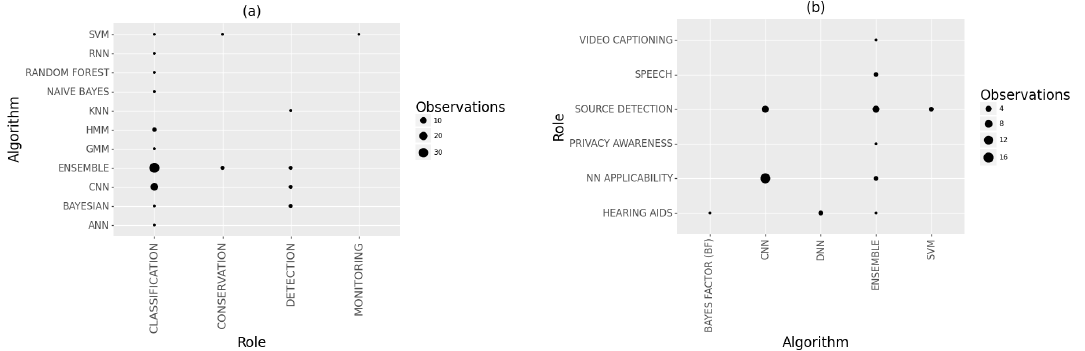
Figure 14. Algorithms used for different acoustic roles in ( a ) bioacoustics and ( b ) general acoustics